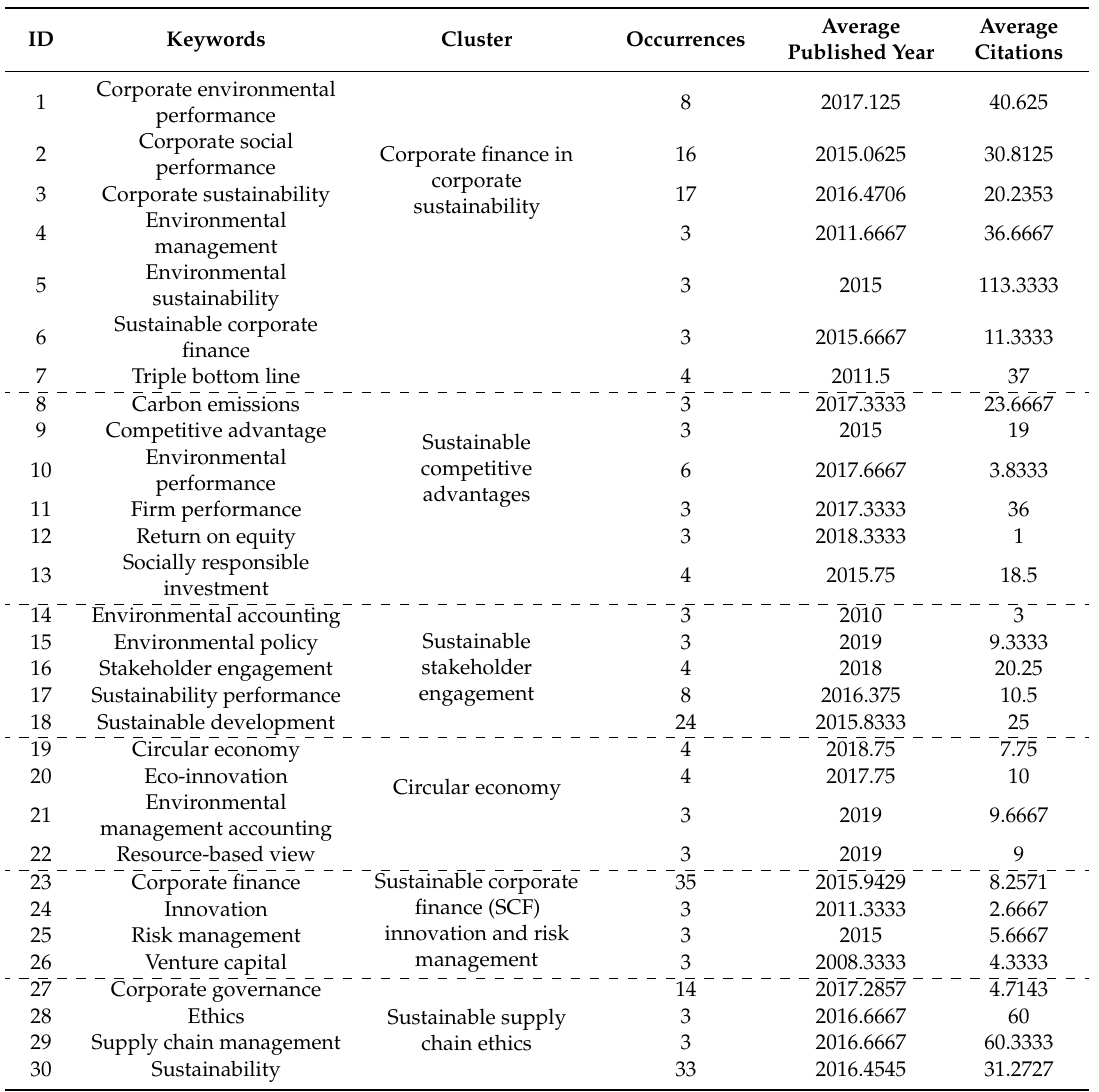
Table 2. Co-occurrence of author